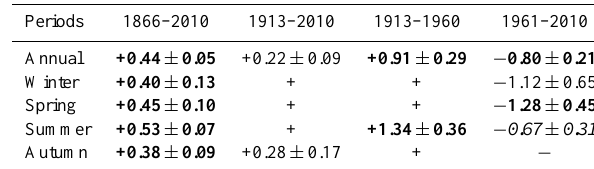
Table 3. Annual and seasonal trends for the estimated TCC mean series in Spain over the 1866–2010 period and different subperiods. The values are expressed as % per decade. Bold, italic and regular numbers indicate trends with significance level higher than 99%, 95% and 90%, respectively. For lower levels of significance only the sign of the trend is